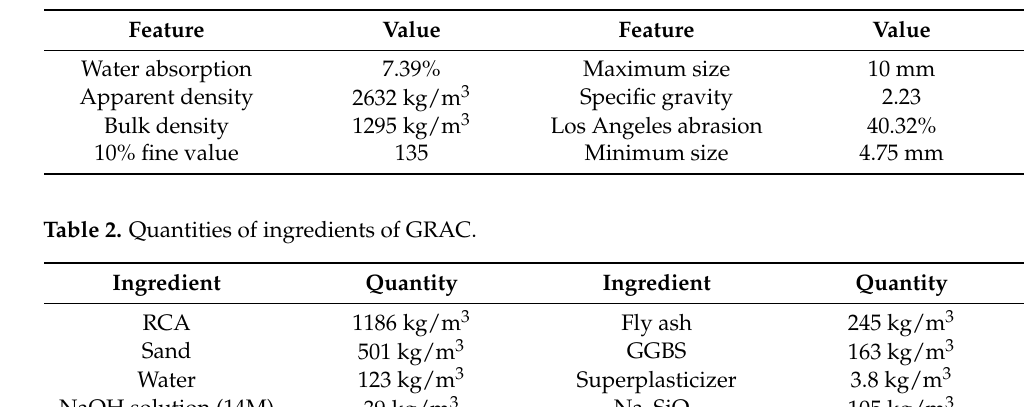
Table 1. Different features of recycled aggregates.